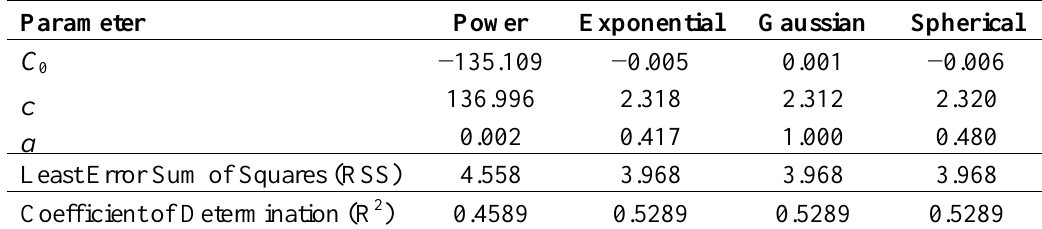
Table 3. Parameters of the four fitted theoretical